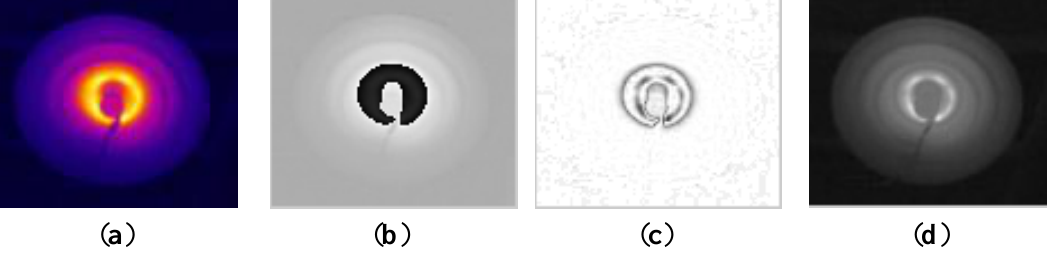
Figure 6. Comparison of images in HSI color space; ( a ) IR image of insulator; ( b ) H component image; ( c ) S component image; and ( d ) I component